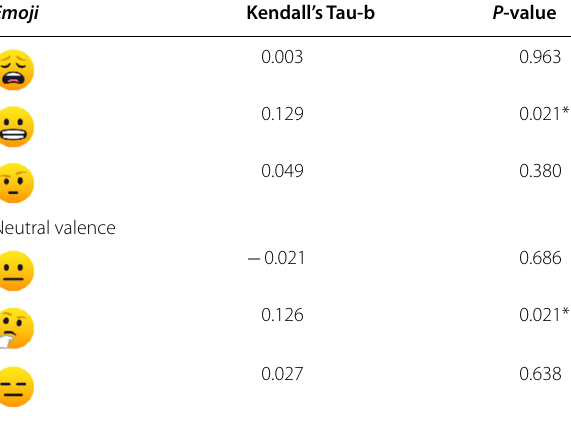
Table 3 Correlations between mean overall acceptance